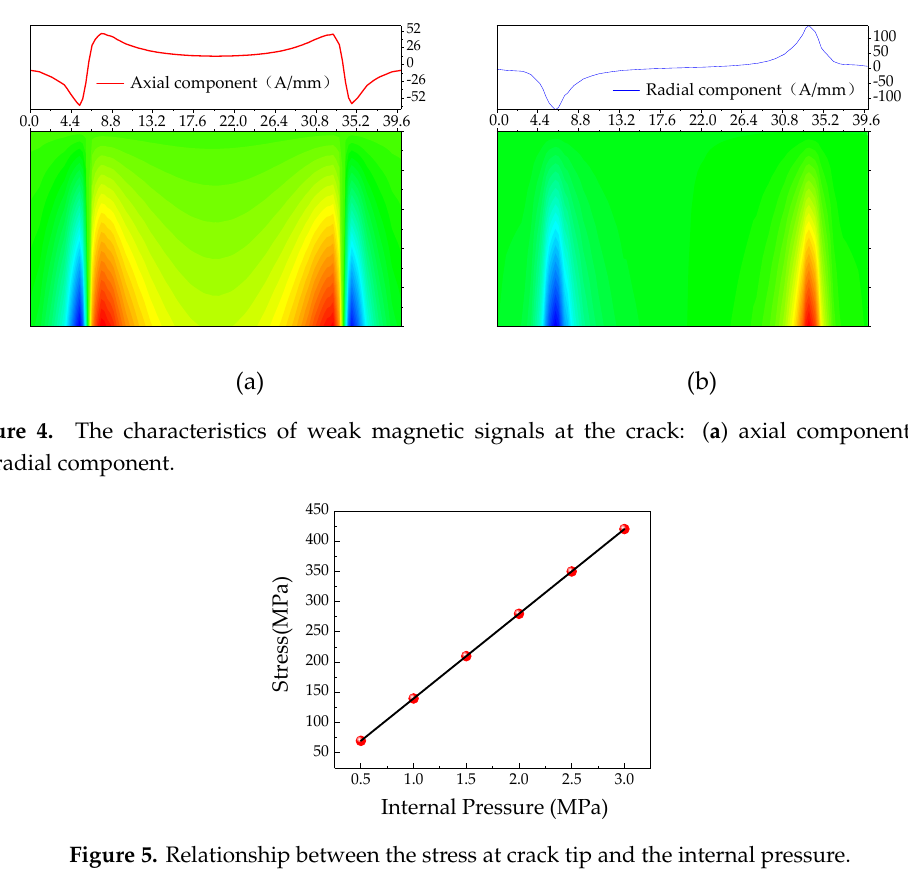
Figure 5. Relationship between the stress at crack tip and the internal pressure.